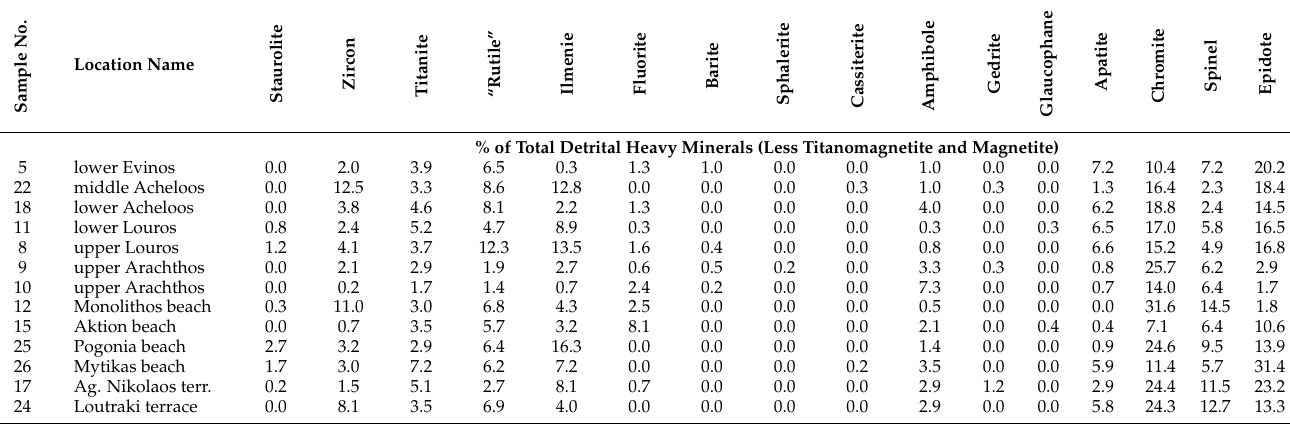
Table 2. Modal abundance of heavy mineral grains *.